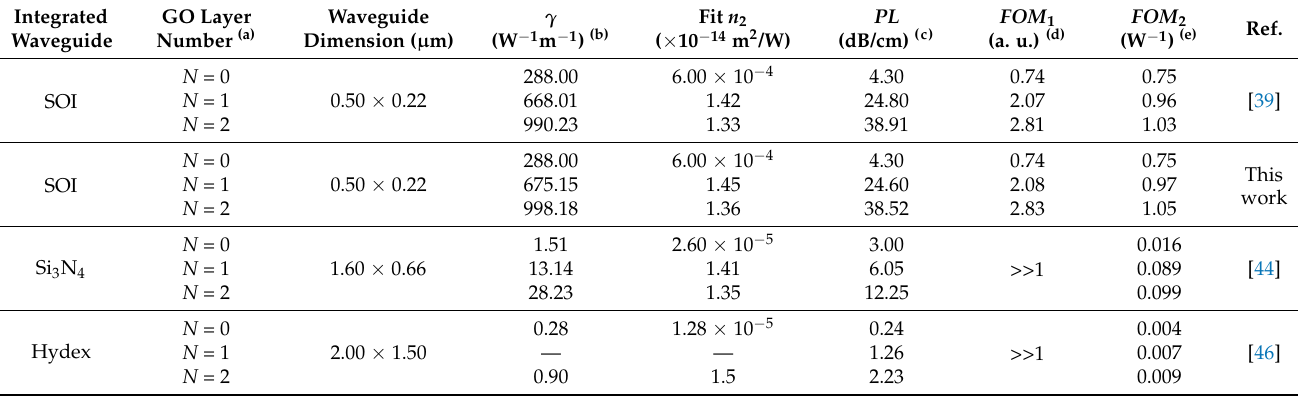
Table 1. Comparison of nonlinear optical performance of different integrated waveguides incorporat- ing GO. FOM: figure of